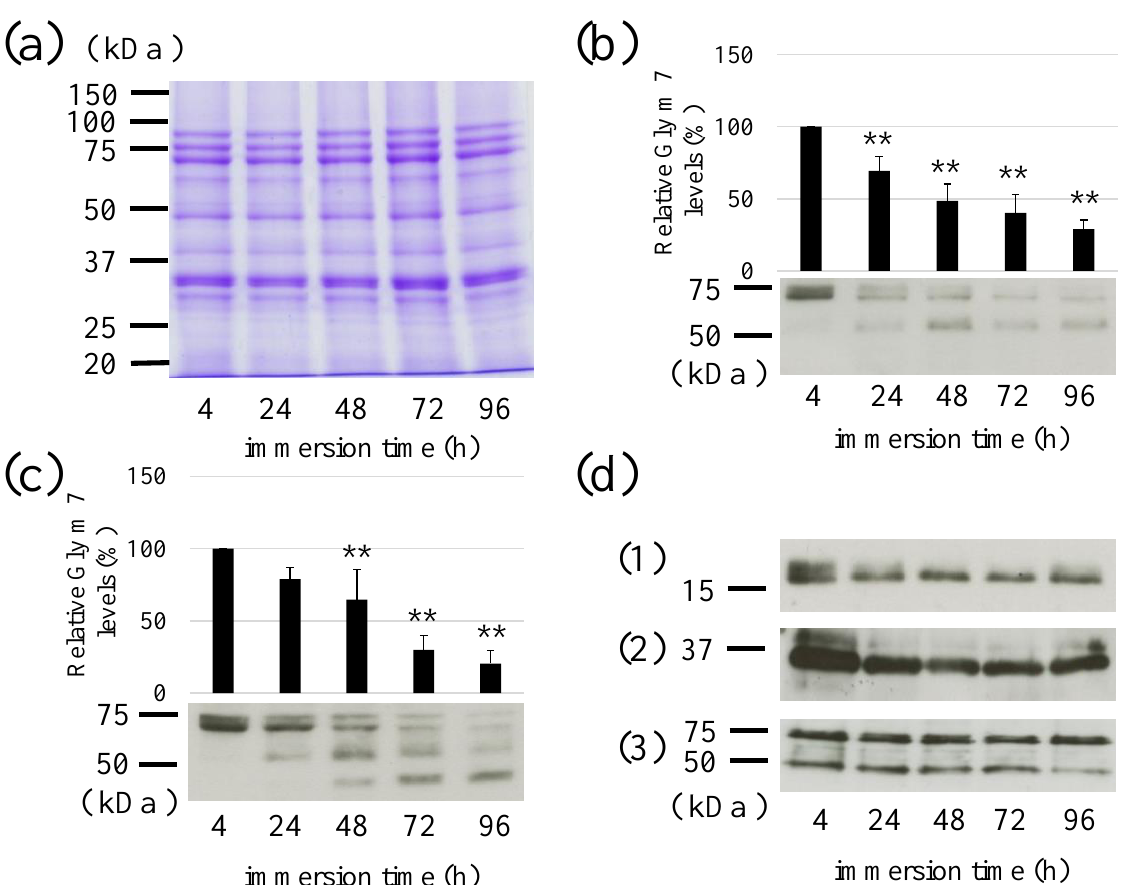
Figure 8. Effect of soybean immersion time on Gly m 7 and other allergens. Dried mature soybeans were immersed in dH 2 O for the indicated time (4, 24, 48, 72, and 96 h), and the immersed soybeans were extracted to test proteins or allergen levels. ( a ) Total protein pattern detected by Coomassie Brilliant Blue staining; ( b ) Gly m 7 levels detected by raised anti-peptide antibody; ( c ) Gly m 7 biotin moiety detected by horseradish peroxidase-labeled streptavidin; ( d ) other allergen levels detected by the specific antibodies. ( 1 ) Gly m 4, ( 2 ) Gly m Bd30K, and ( 3 ) Gly m 5. **: p < 0.01.